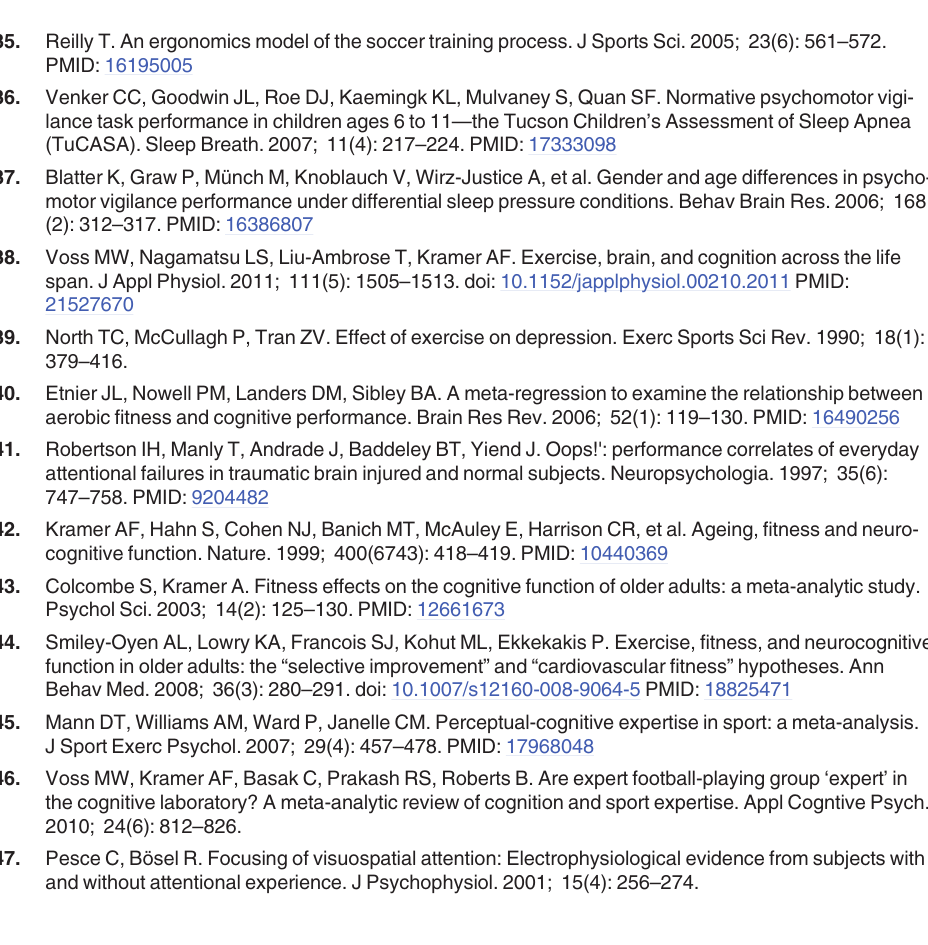
PLOS ONE | DOI:10.1371/journal.pone.0123898 April 7,